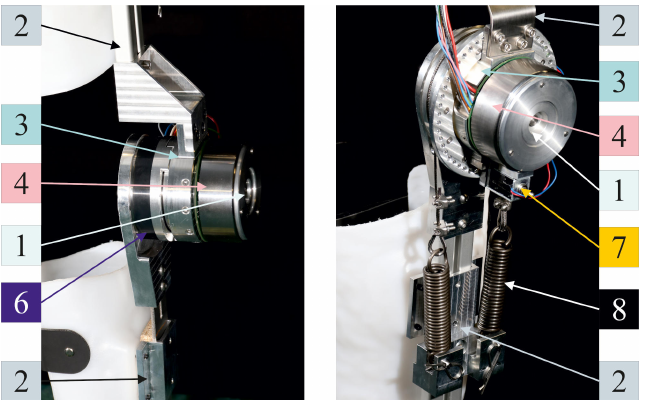
Figure 3. Photos of the RA ( left ) and CPEA ( right ) including the 30.8Nm/rad PE integrated in the hip and knee joint. The numbering according to Figure 2 is still applied.